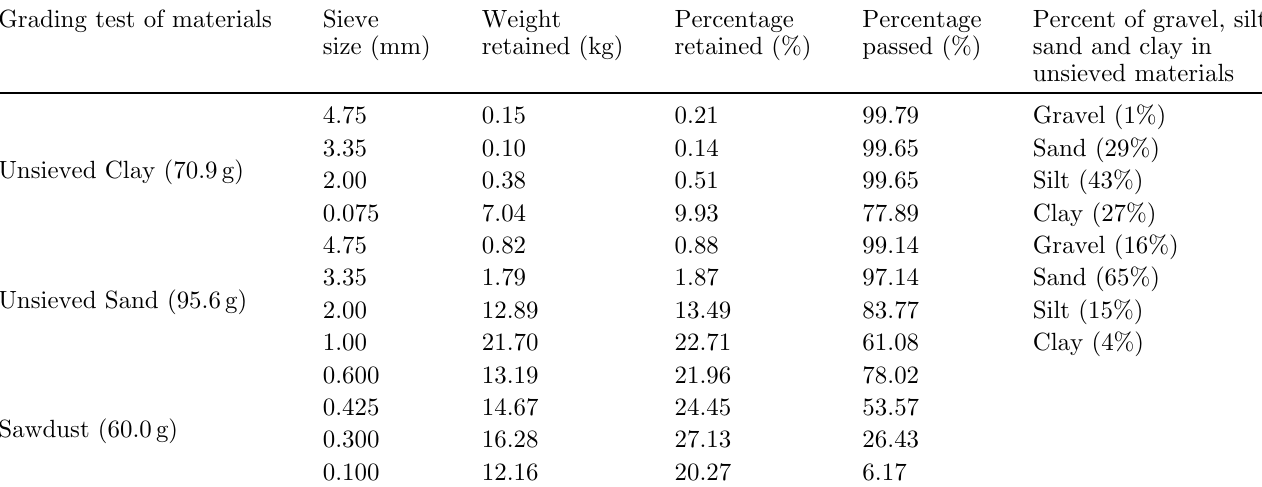
Table 2. Summary of particle size distribution for composing the ceramic liner (one batch).